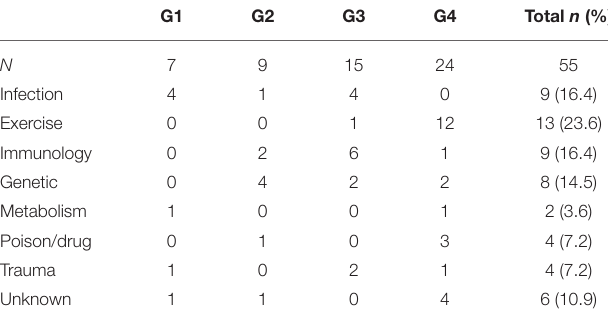
TABLE 2 | Etiology of RM among